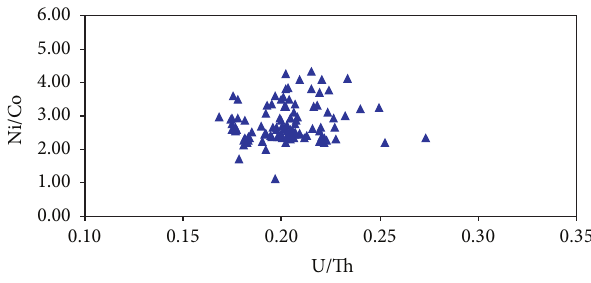
Figure 7: The cross plot showing the relationship between U/Th ratios and Ni/Co ratios of Miocene source rocks in the Qiongdong- nan Basin. Note: the samples in the chart are from the whole region of the basin. The information of the samples mainly represents the shallowwaterareabecausemostofthewellsdistributeintheshallow water area (mainly in delta or coastal area).